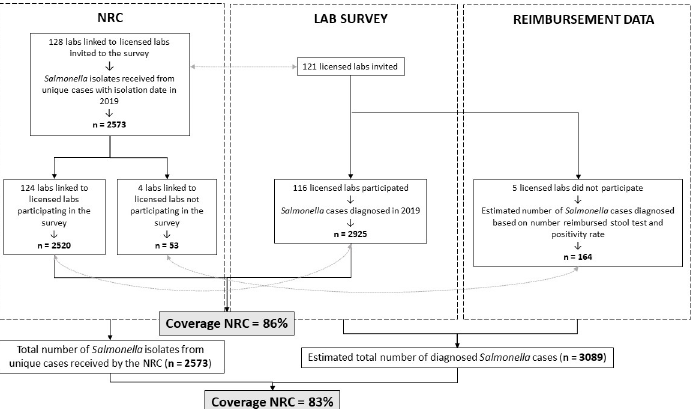
Fig 3. Linking peripheral laboratory sites that sent isolates to the National Reference Center (NRC) with licensed medical laboratories that were invited to the survey to estimate the coverage of the NRC surveillance system, Belgium,